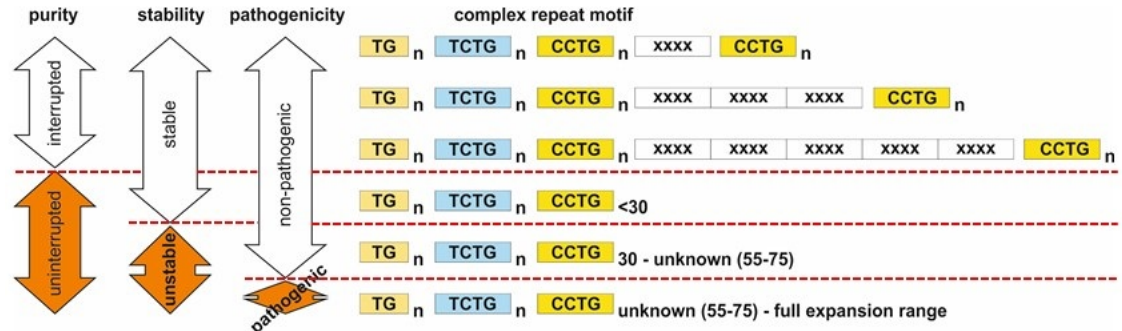
Figure 2. Schematic representation of the suggested division of CNBP alleles based on the structure of the CCTG part of the complex (TG) n (TCTG) n (CCTG) n repeat tract, regarding sequence purity, inheritance and pathogenicity.